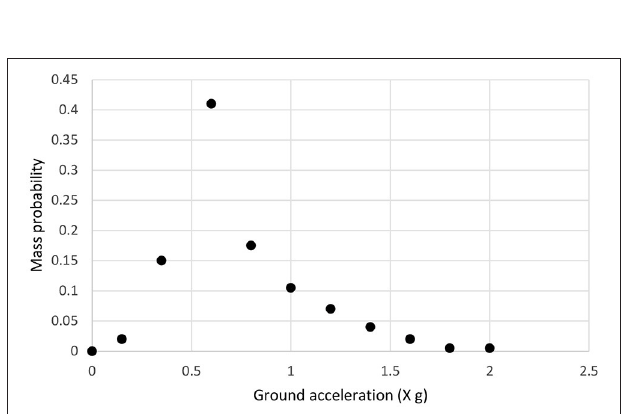
FIGURE 14 | Mass probability distribution of ground acceleration, Oaxaca.